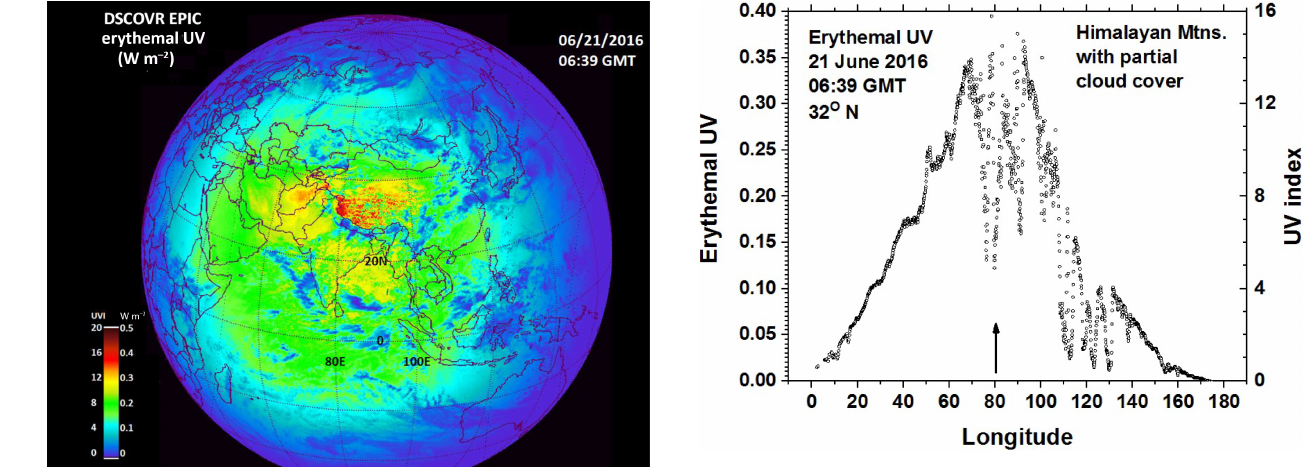
Figure 22. Erythemal Irradiances in a longitudinal slice at 32 ◦ N through a portion of the Himalayas. Local solar noon is at 80.25 ◦